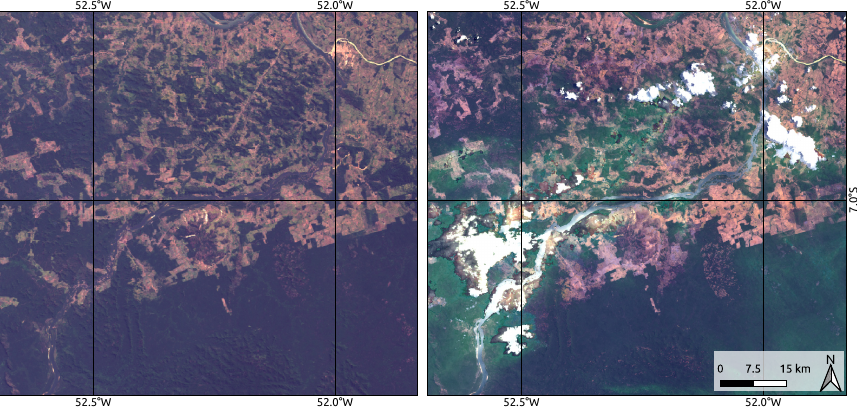
Figure 3. Reference image ( left ) and the later instant ( right —14 September 2020) for Area 1. Repre- sentations in natural color composition.